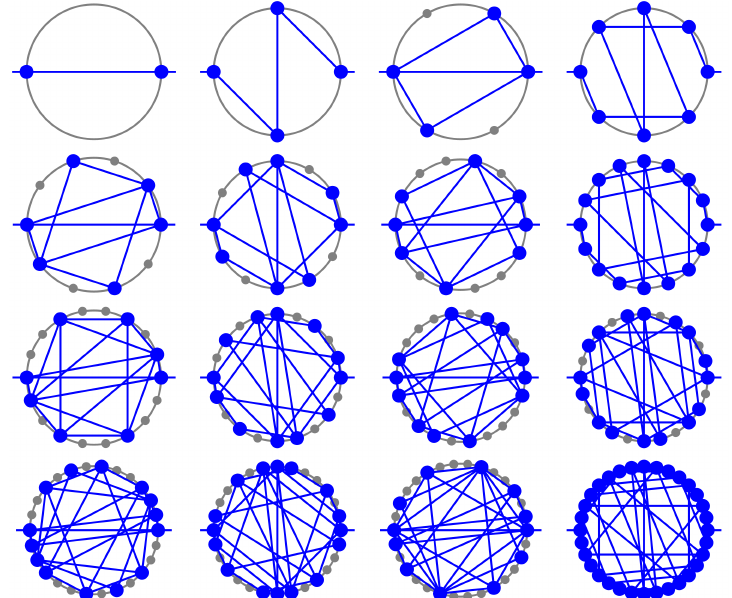
Figure 2. Two-dimensional base space graphs for p = 1 through p = 16 (read left to right, top to bottom). The grey circle represents S 1 and small grey dots (sometimes obscured by larger blue dots) represent 2 p equally spaced positions S 1 . The graph, G p , is shown in blue. The vertices of the graphs j π i represent terms of the form e p , j ∈ Z . The edges (blue lines) represent steps in the unit increase progression (Definition